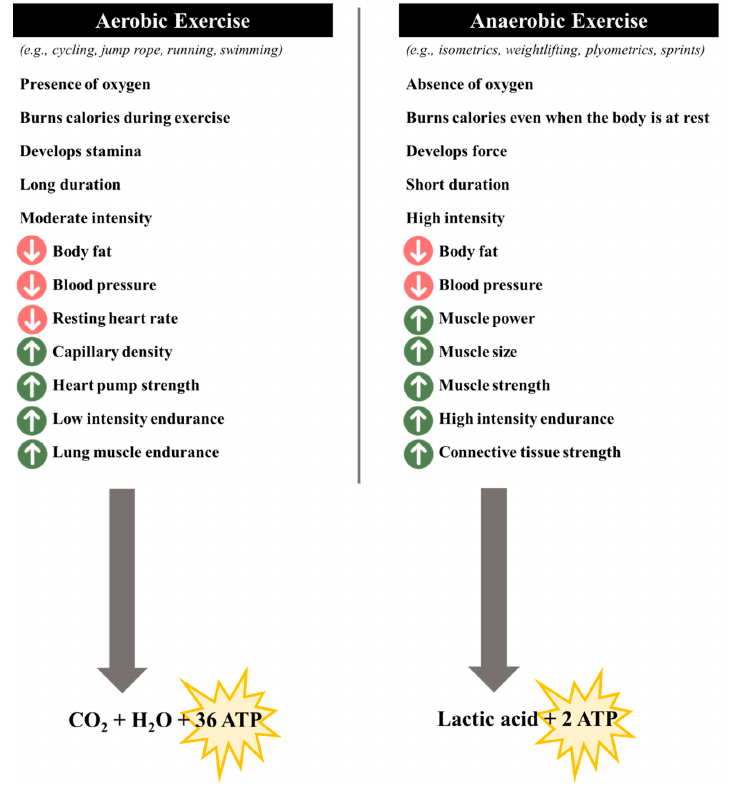
Figure 4. Main differences between aerobic and anaerobic sports.